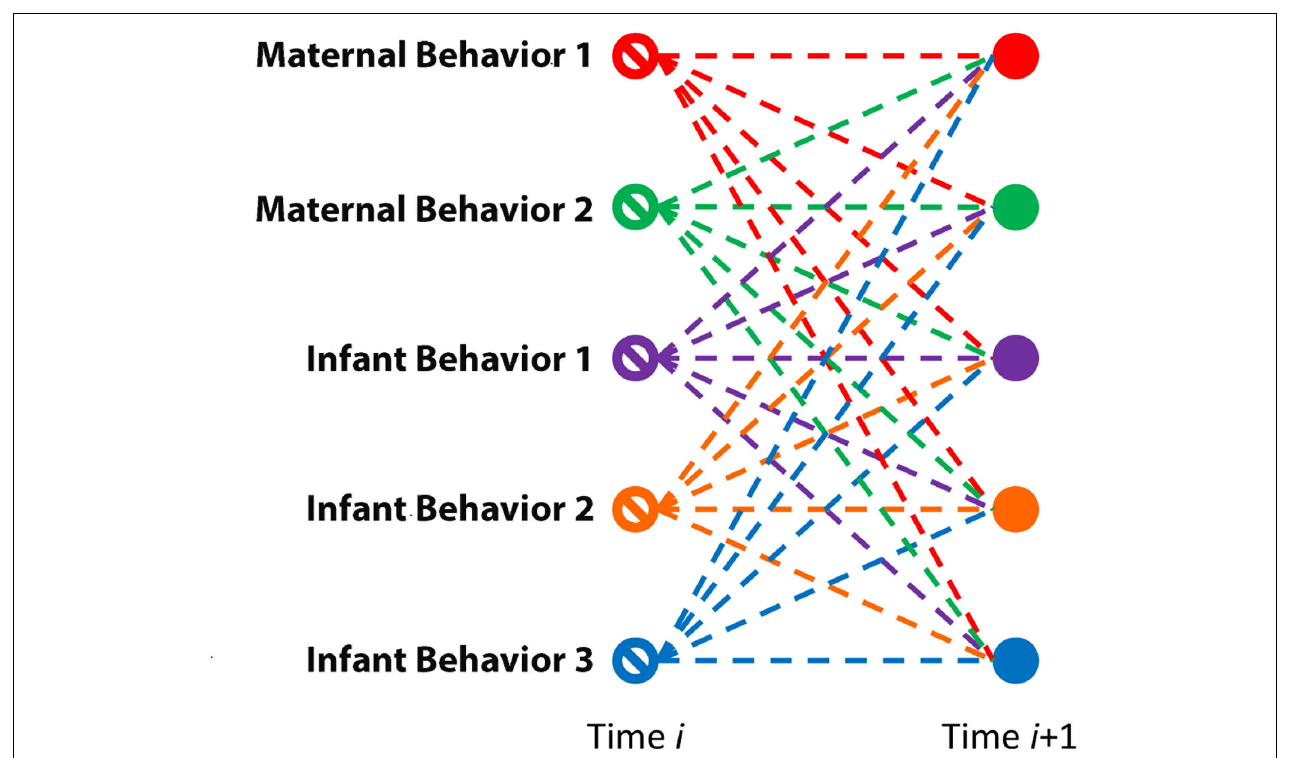
FIGURE 1 | VAR(1). Schematic of relationships modeled by vector autoregression at a lag of one time